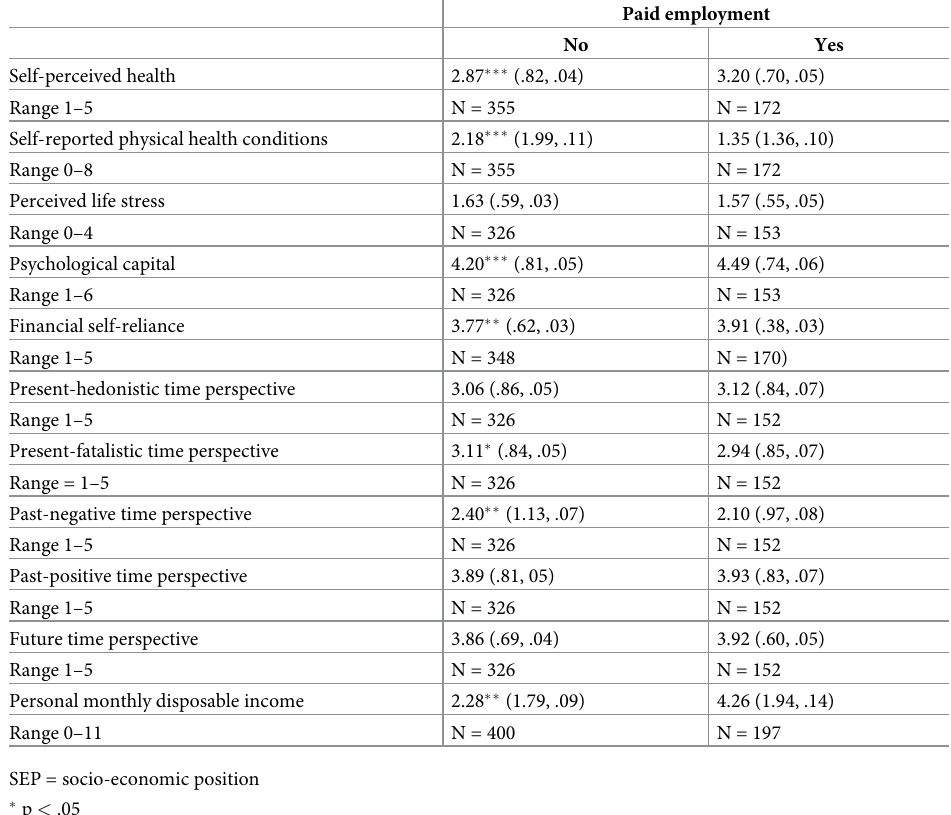
Table 2. Mean scores (SD, mean std. errors) of model variables for paid employment (SEP indicator).